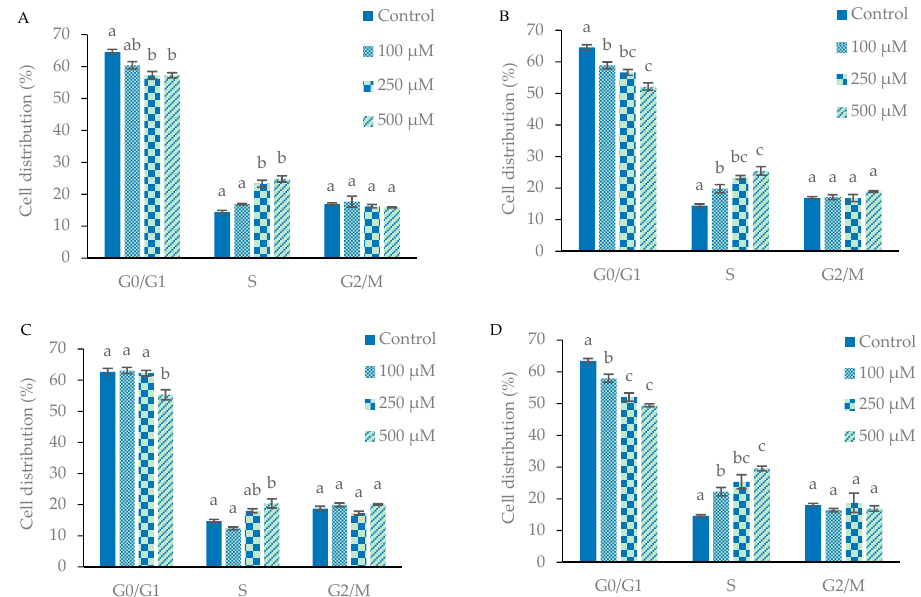
Figure 4. Effects of chlorogenic acid ( A ); caffeic acid ( B ); 3-phenylpropionic acid ( C ) and MIX ( D ) treatments for 24 h on Caco-2 cell-cycle distribution as determined by flow cytometry. Data are represented as mean ± SE. Bars not sharing the same letters within each cell cycle are significantly different ( p < 0.05) from each other.